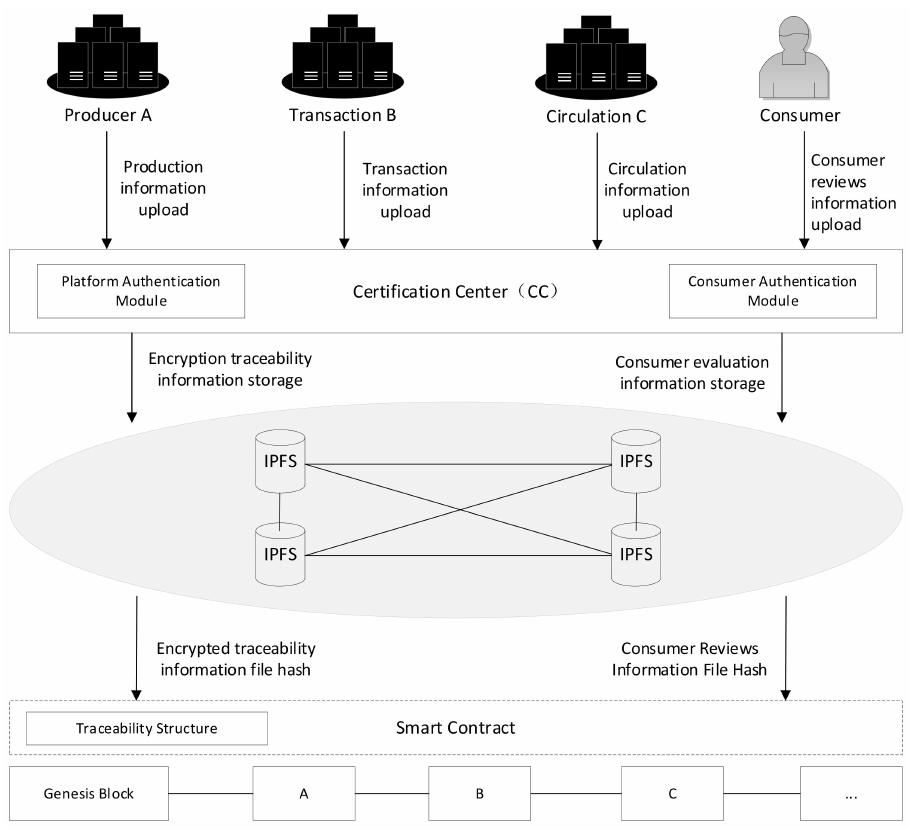
Figure 4. Product certification technology architecture diagram that integrates blockchain technology and the traceability structure proposed in this